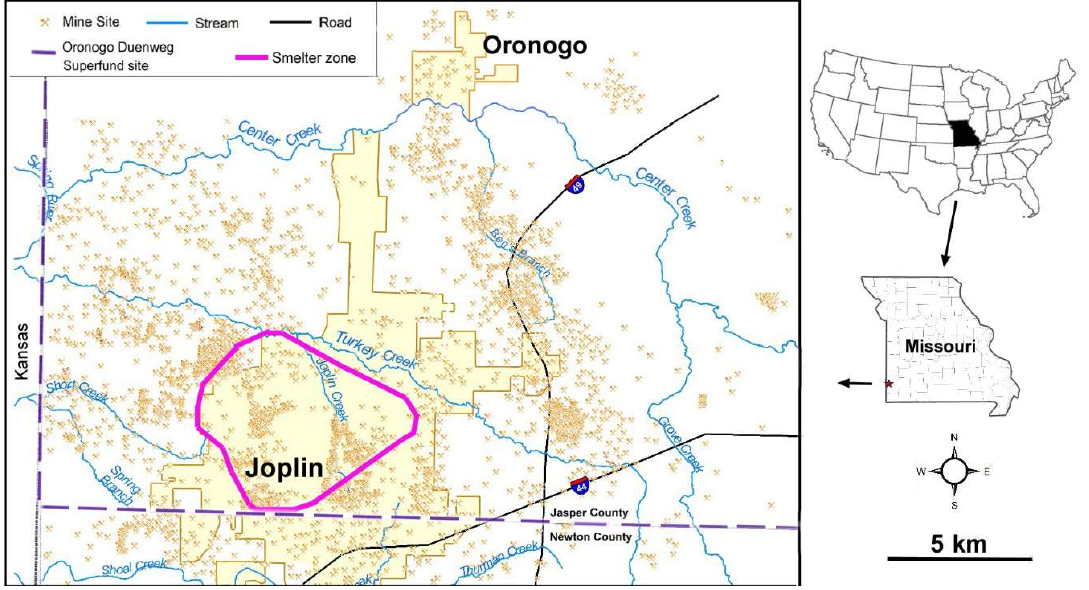
Figure 1. Study area showing the historic mine locations around the city of Joplin, the area affected by smelter fallout, and the location of Turkey Creek and Center